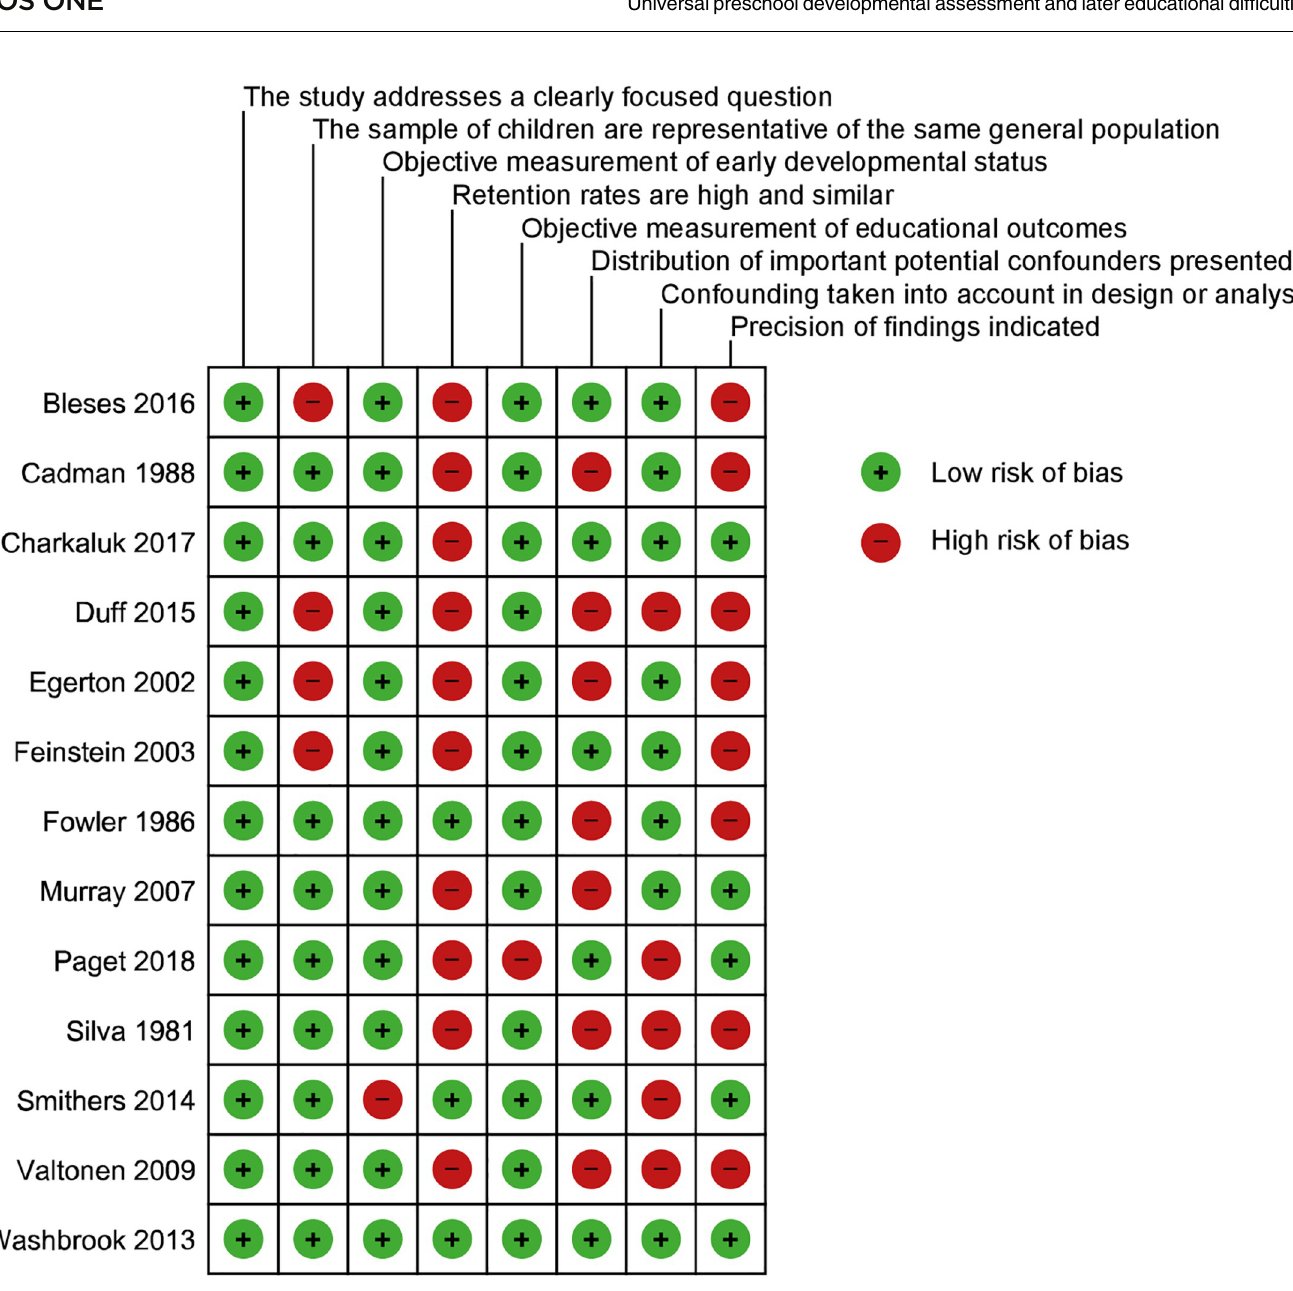
Fig 2. Risk of bias assessment. Risk of bias assessment using bespoke checklist based on Scottish Intercollegiate Guidelines Network and the Critical Appraisal Skills Programme